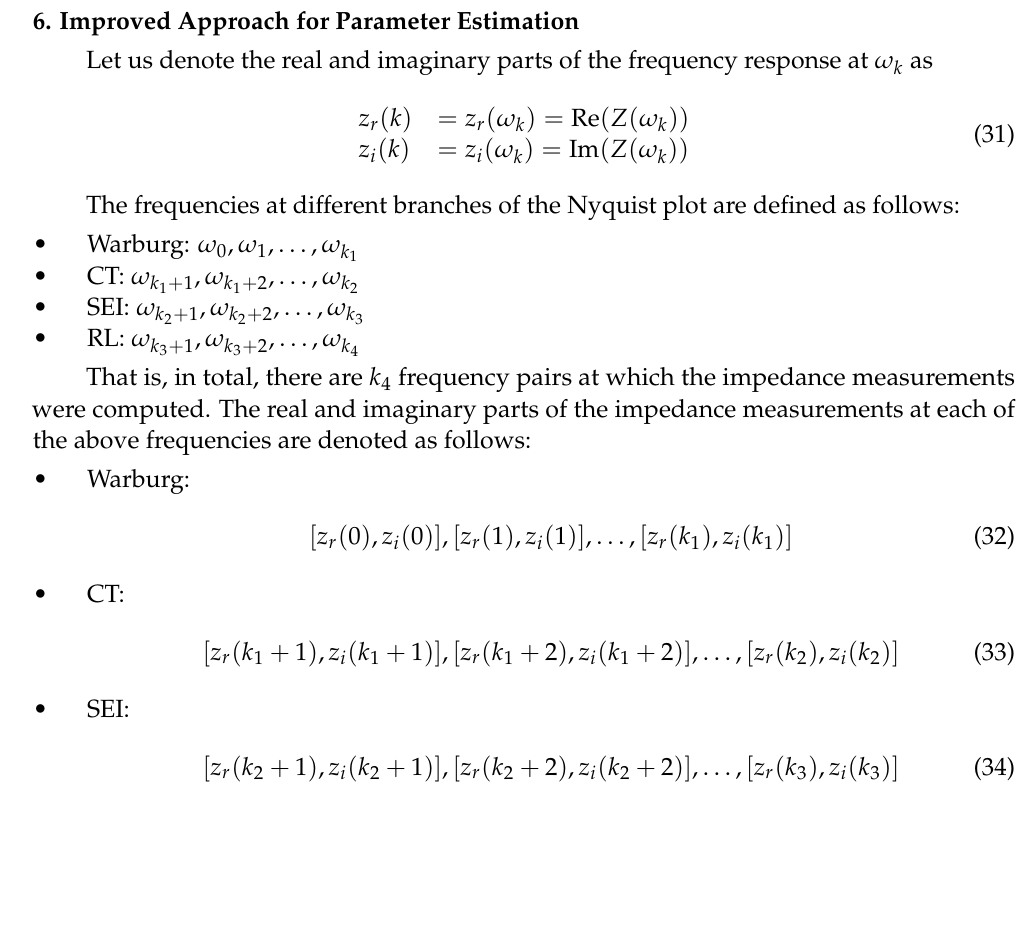
Figure 3. Effect of measurement noise on performance. Blue ‘.’ marks show the impedance measure- ment at various SNR levels. The dashed line shows the re-created Nyquist plot using the estimated values based on the previous approach (Section